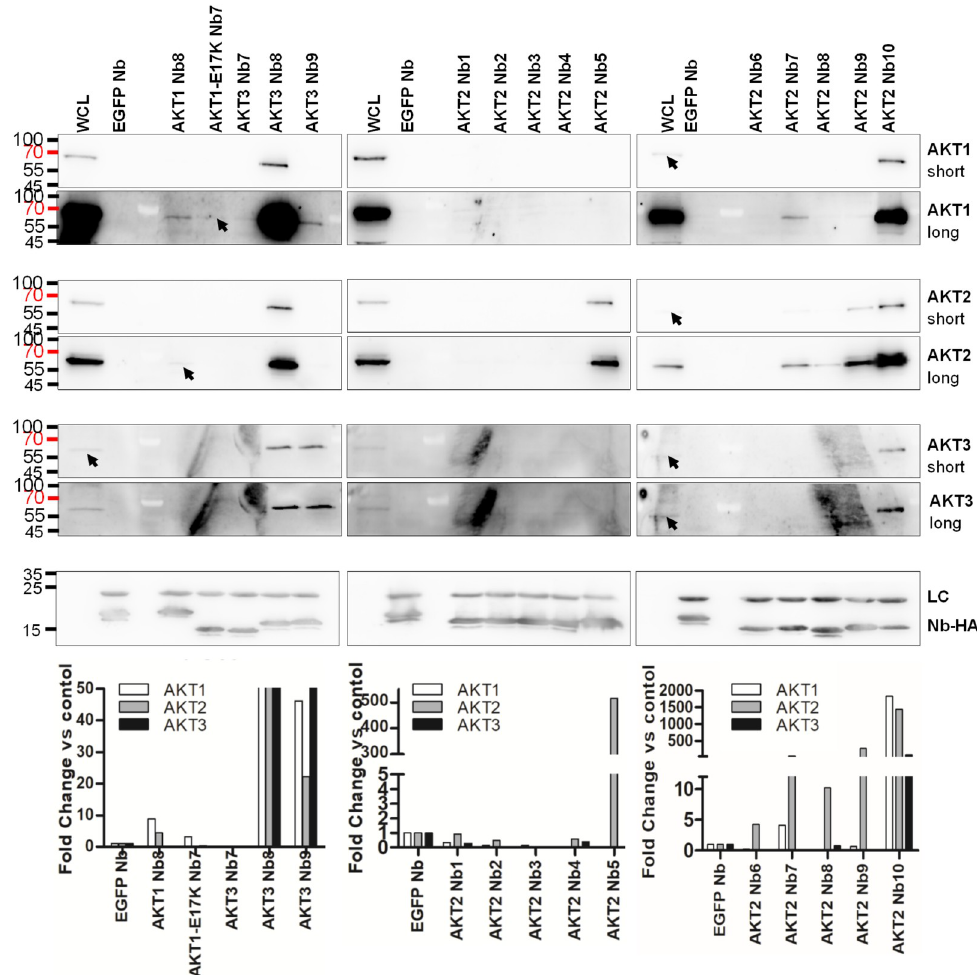
Fig 3. Co-IP of AKT isoforms using AKT1-, AKT1E17K-, AKT2- and AKT3-Nbs. Immunoprecipitation of endogenous AKT1, AKT2 or AKT3 from MDA-MB-231 cells with recombinantly produced HA-tagged Nbs. Representative for three repeated experiments. For the AKT isoforms a pair of panels is shown for each isoform with a short exposure time and a long exposure time. The short exposure panel contains no saturated pixels. WCL = whole cell lysate, EGFP Nb = negative control of anti-HA-agarose incubated with the EGFP Nb and MDA-MB-231 lysate and LC = Light-Chain. Nbs were blotted using an anti-HA antibody, AKT1, AKT2 and AKT3 were detected using the C73H10, D6G4 and 62A8 isoform-specific Ab clones respectively. All nanobodies (Nb-HA) were efficiently expressed in E . coli . Uncropped blots are available in S1 Raw